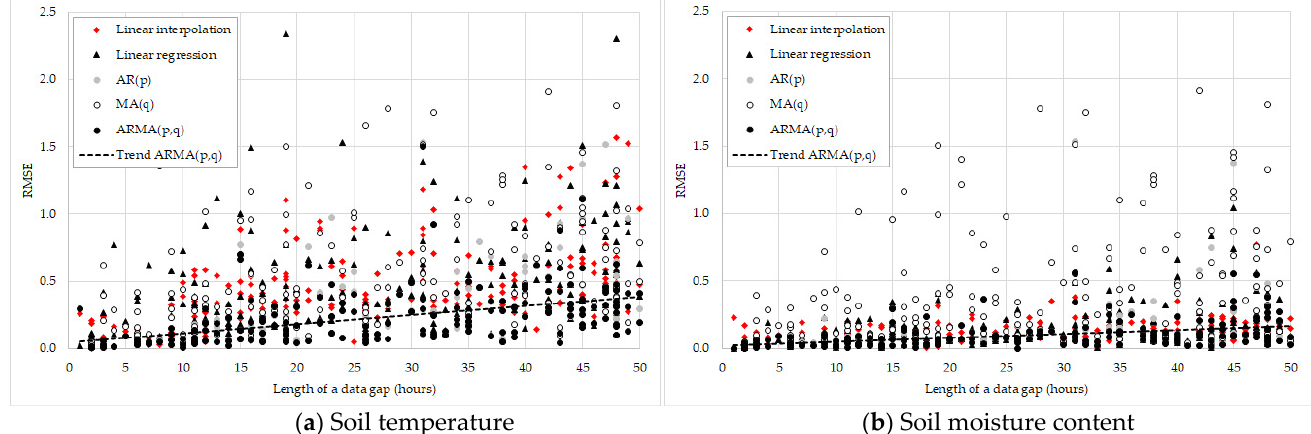
Figure 2. The dependence of RMSE on data gap length (N = 188). Calculated by the authors based on hourly time